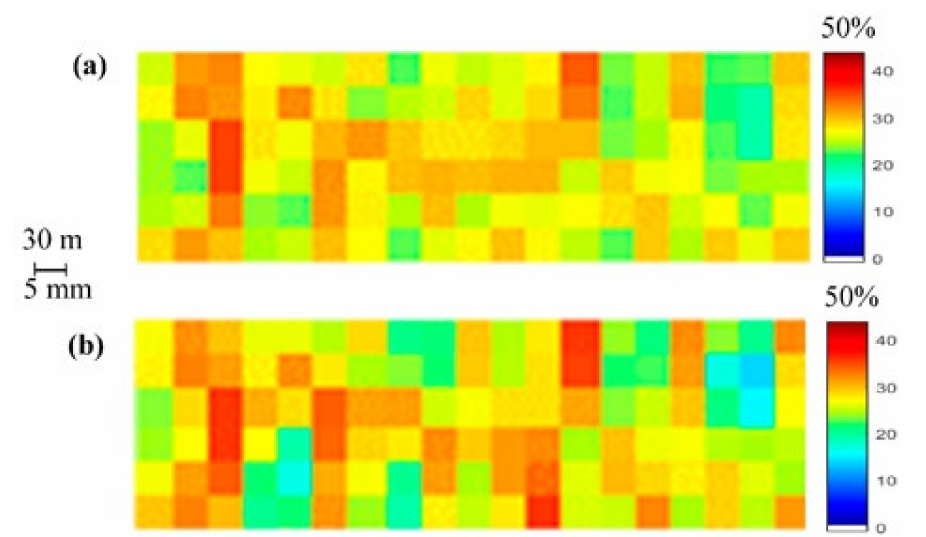
Figure 11. SMC maps: ( a ) produced by the estimation using the weight-based methodology and ( b ) produced by field measurements (7 April 2018).